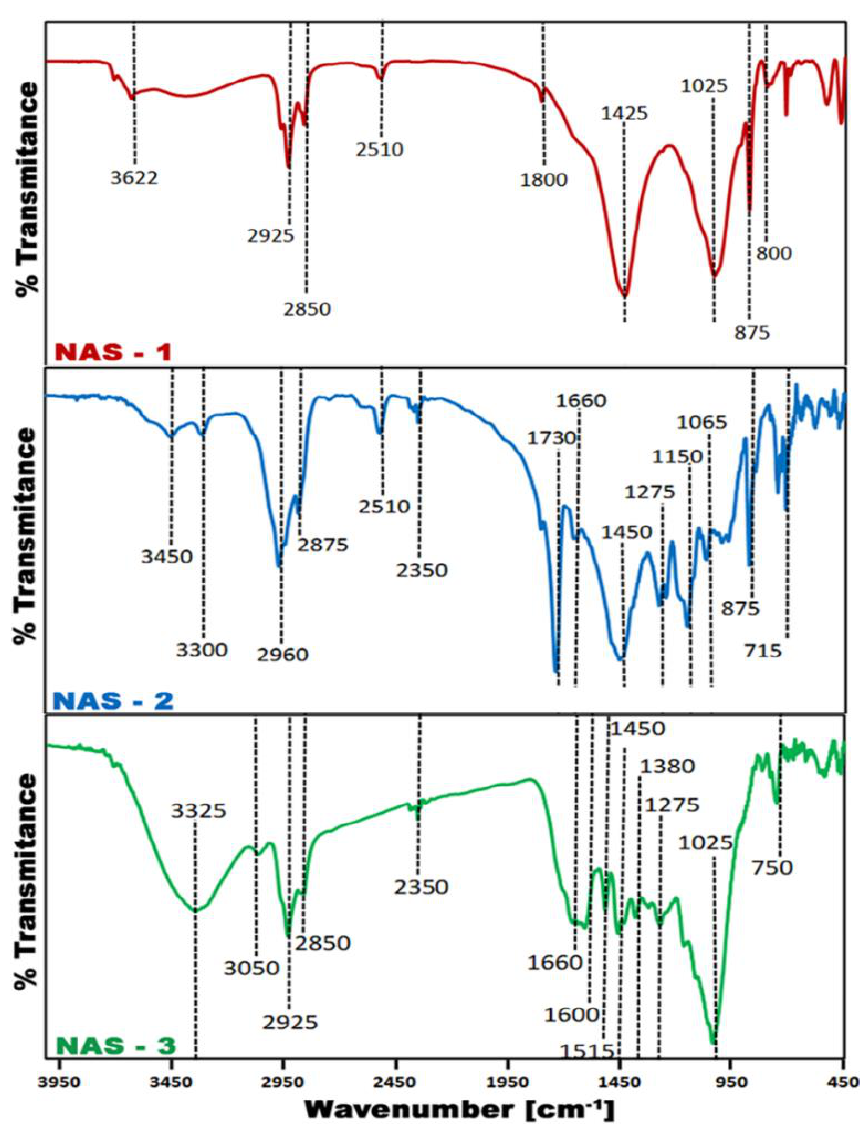
Figure 3. FT-IR spectra of the three waste